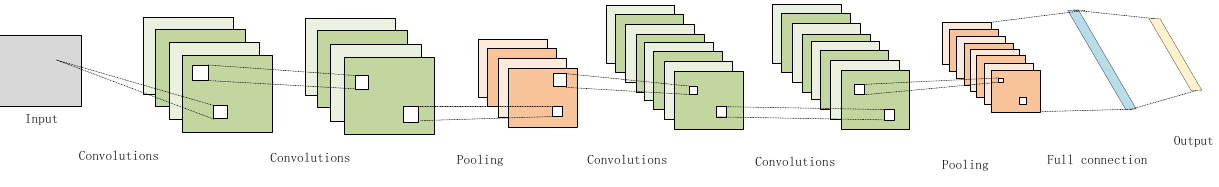
Figure 2. CNN Model Structure.